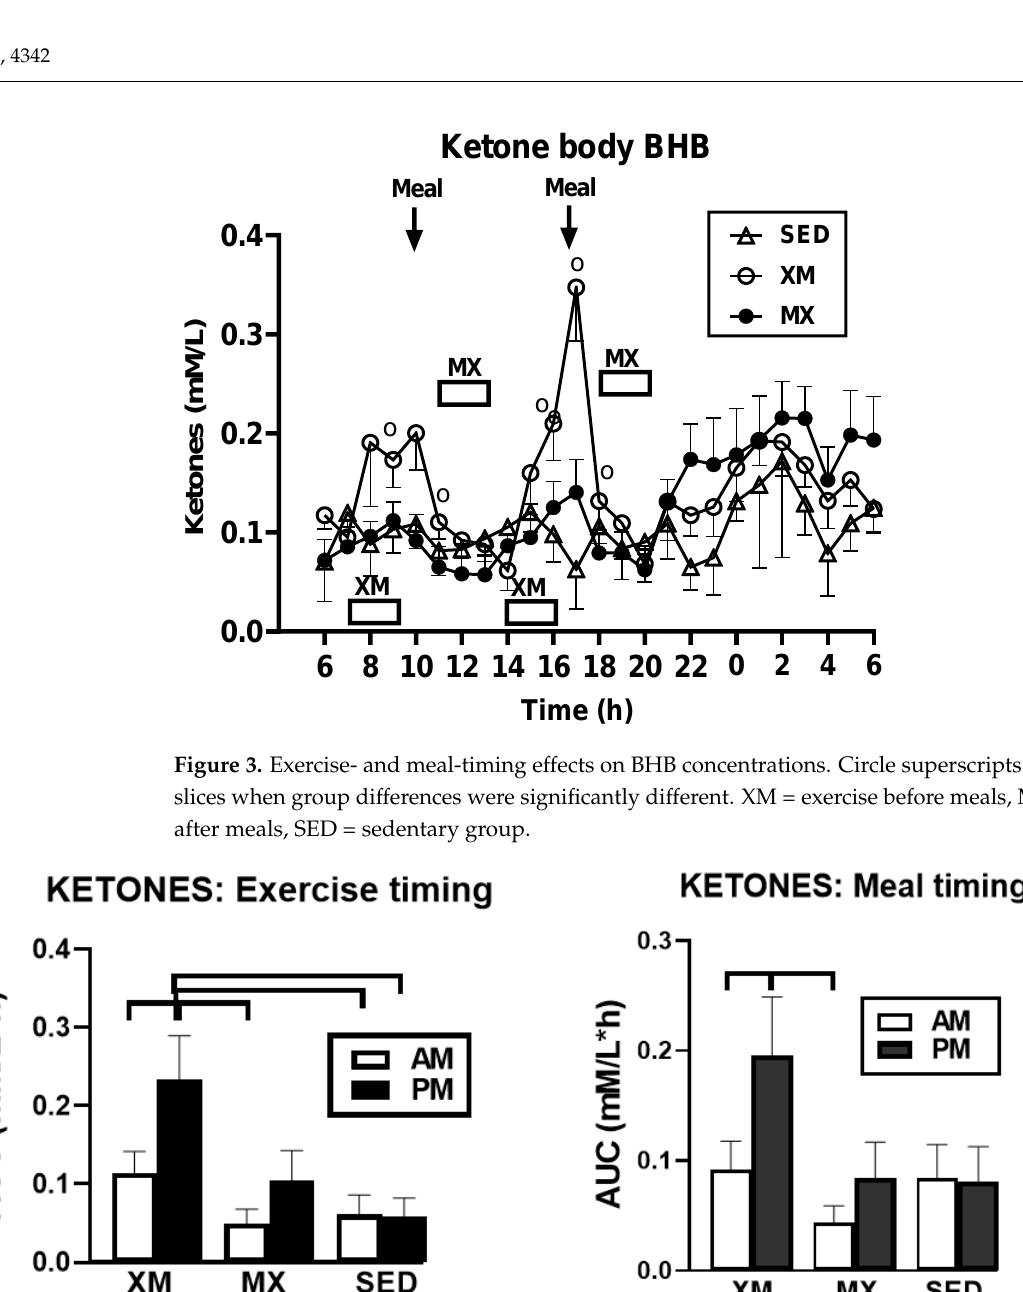
Figure 5. Exercise- and meal-timing effects on glucose concentrations ( left panel) and AUCs ( right panel). Circle super- scripts identify time slices when group differences were significantly different ( left panel). Timing analysis of group AUCs (treatment indicated in the top abscissa row) is presented for time periods assigned to XM and MX exercise (indicated in the bottom abscissa row). Bracket ( right panel) identifies asignificant within-group difference in postprandial timing of XM trial. XM = exercise before meals, MX = exercise after meals, SED = sedentary group.